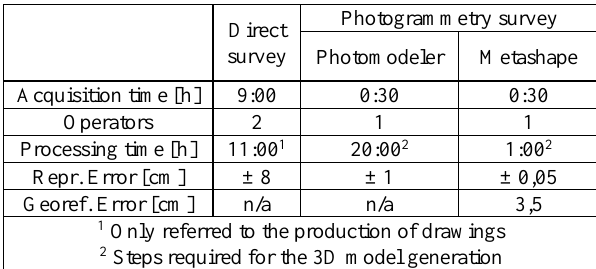
Table 9 . Comparison between direct and photogrammetry survey with both Photomodeler (old) and Metashape (new) approach. Data are referred to a portion of the study of 4,5 m 2